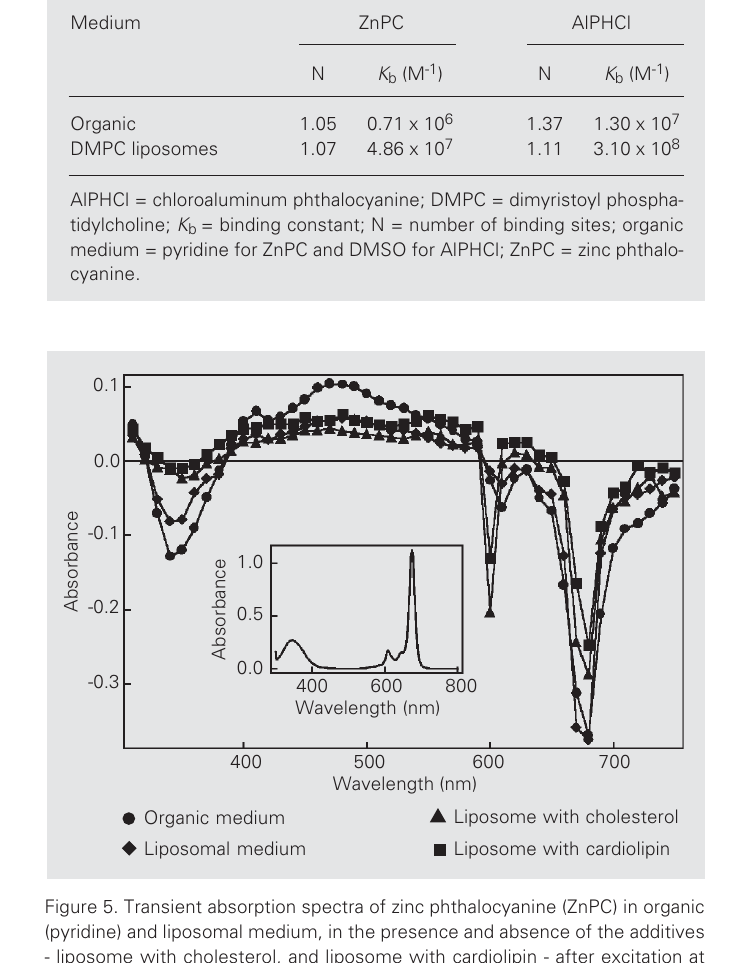
Table 3. Equilibrium constants of ZnPC and AlPHCl binding to BSA. Medium